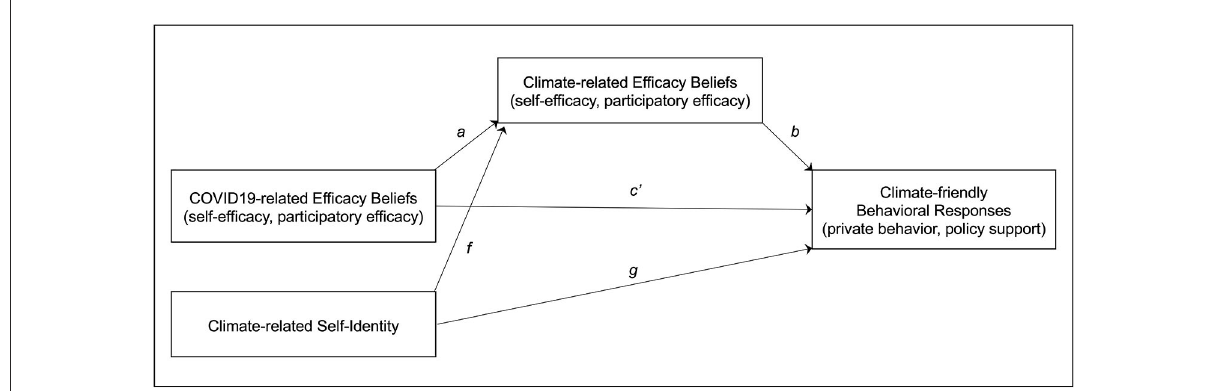
FIGURE2 Moderation model of Study 2 assuming that the transfer of efficacy beliefs between the COVID-19 and the climate crises is more likely if the two crises are perceived as